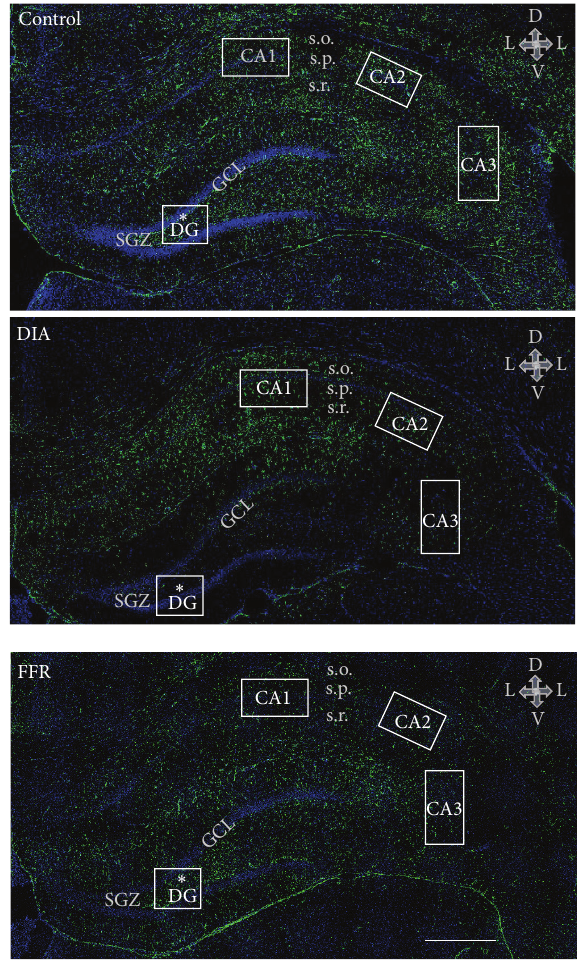
Figure 1: The rat hippocampus. Coronal brain sections from young female rats showing the hippocampus of control, dehydration- induced anorexia (DIA), and forced food-restricted (FFR) rats. The histological sections from the three experimental groups were immunostained for GFAP (green), and nuclei were labeled with DAPI (blue). The hippocampal regions for this study included the cornus ammonis 1–3 (CA1, CA2, and CA3) and the dentate gyrus (DG). Nuclear and astrocyte densities were estimated in the stratum oriens(s.o.)andstratumradiatum(s.r.)ofCA1,CA2,andCA3,while the hilus region ( ∗ ) was studied for the DG (squares). Other regions are indicated for anatomical reference: stratum pyramidale (s.p.), granular cell layer (GCL), and subgranular zone (SGZ). Arrows show anatomical orientation: dorsal (D), ventral (V), and lateral (L). Scale bars correspond to 200 𝜇